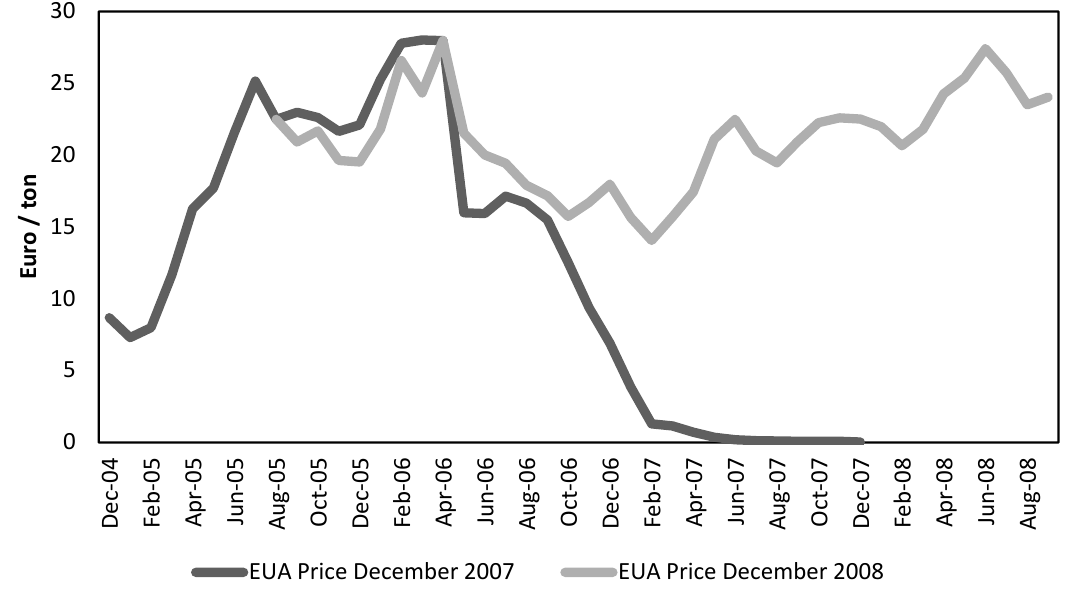
Figure 4. EU ETS carbon emission allowance